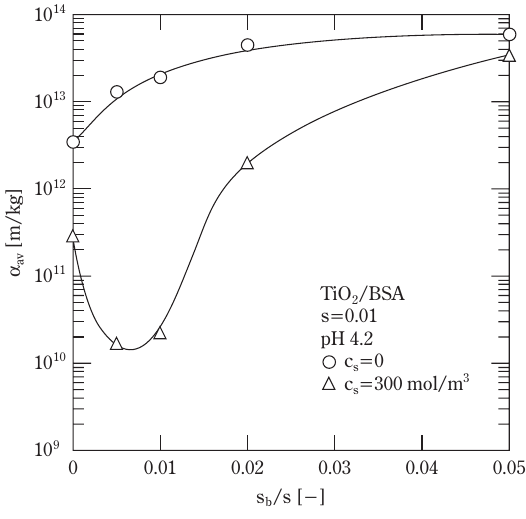
Fig. 21 Effect of mixing ratio of proteins on average specific fil- tration resistance in ultrafiltration of particle/protein mixtures.